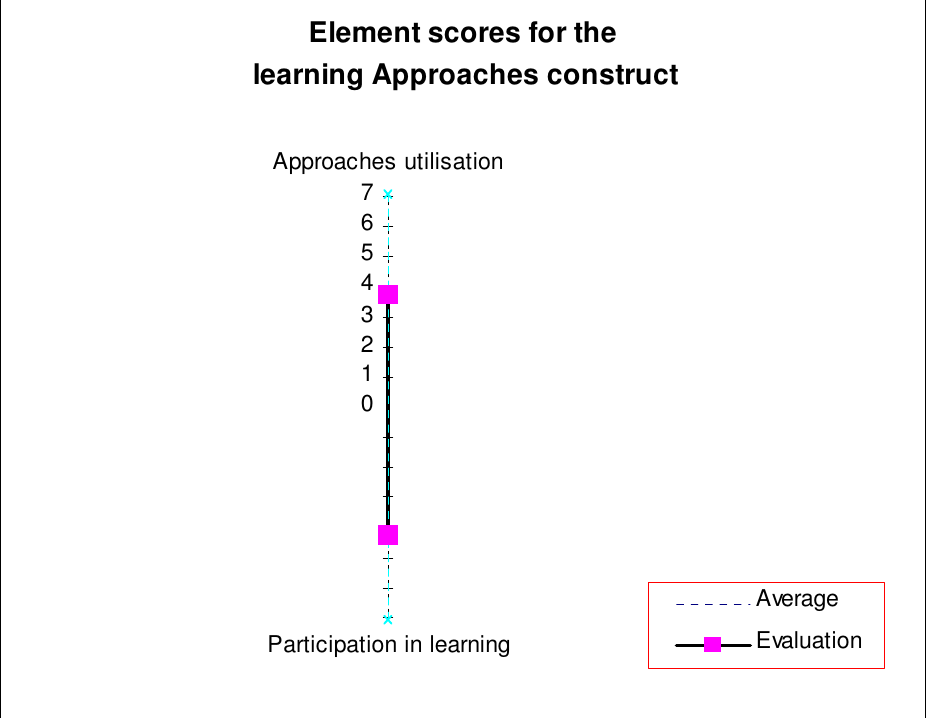
Figure 5: Assessment results for the learning approaches